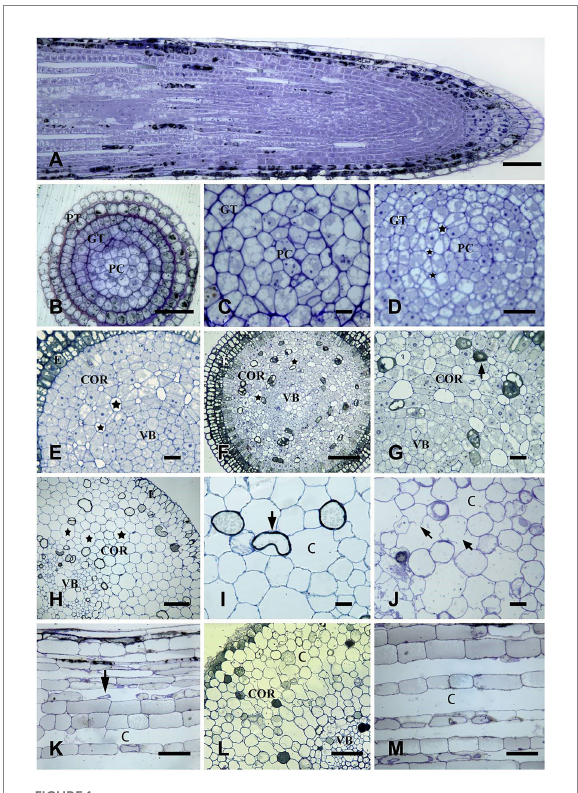
FIGURE 1 The formation process of aerenchyma in Nelumbo